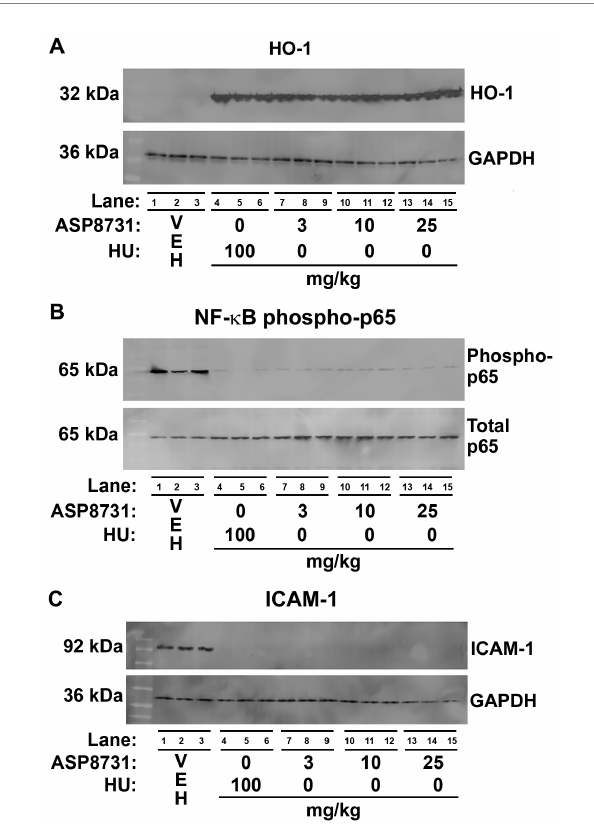
FIGURE 3 Bach1 inhibitor ASP8731 had anti-inflammatory properties in Townes HbSS mice. Townes HbSS mice ( n = 3 mice/treatment, 2 males and 1 female) were gavaged once daily for 14 consecutive days with vehicle (VEH), ASP8731, or HU at the indicated doses. On the last day of treatment, mice were infused with hemin (3.2 μ mol/kg). Livers were excised 4 h after the infusion of hemin. Proteins in liver were analyzed by Western blots. (A) HO-1 and GAPDH. (B) NF-ĸB phospho-and total p65. (C) ICAM-1 and GAPDH using liver microsomes (A,C) and nuclear extracts (B)